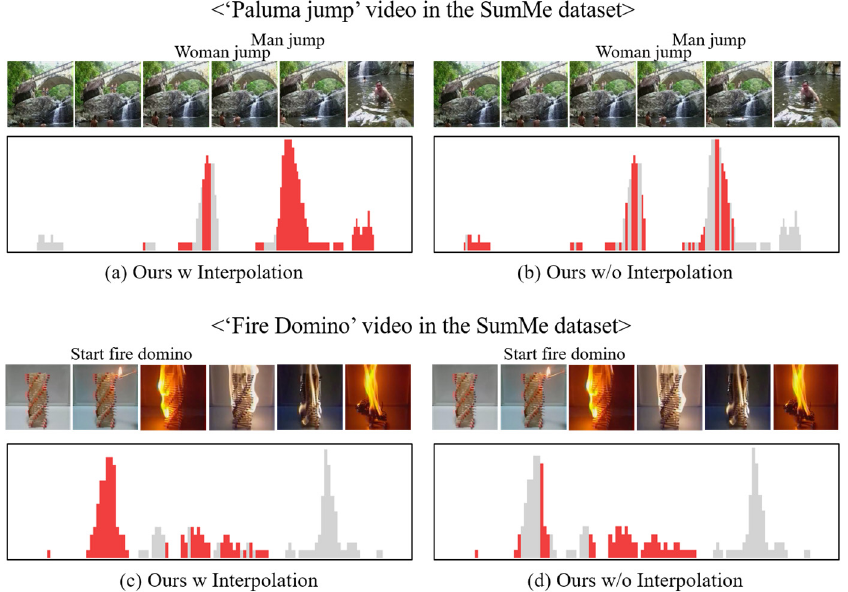
Figure 6. Example of the predicted importance scores by the proposed method and video thumb- nails of the keyframes (The gray color means the importance score and the red color means the selected keyframes by the proposed method).